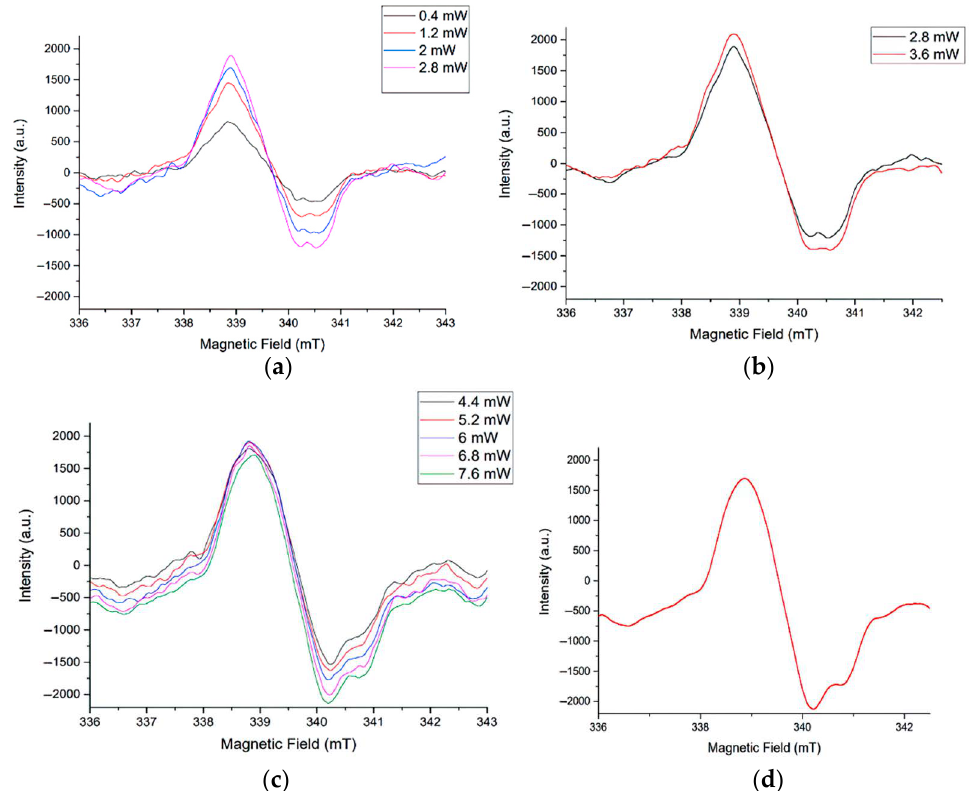
Figure 7. EPR signal saturation spectra for a sample with 25 layers of ZnO coating: ( a ) Changing of the microwave power from 0.4 to 2.8 mW; ( b ) changing of the microwave power from 2.8 to 3.6 mW; ( c ) changing of the microwave power from 4.4 to 7.6 mW; ( d ) averaged EPR spectrum at signal saturation.